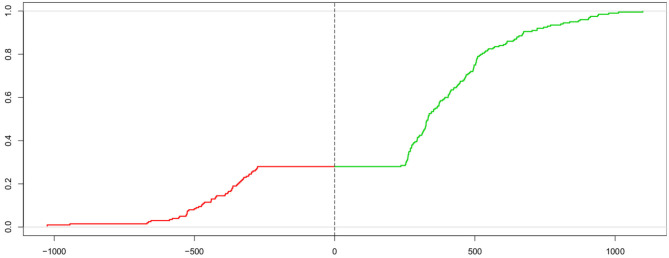
Super-curve of the combined cumulative distribution function of the data used in Figure 1. The horizontal axis depicts the reaction time (with response times of lower threshold passes mirrored at the origin). The vertical axis represents the probability P(X < x). The left (red) part of this curve represents the mirrored cumulative distribution function of the incorrect responses and the right (green) part the cdf of the correct ones. The vertical dashed line indicates the point, where the two separate curves have been joined. The combined curve intersects this line at height 1 − Pc (which, in this case, is 0.28, corresponding to 28 % incorrect responses).